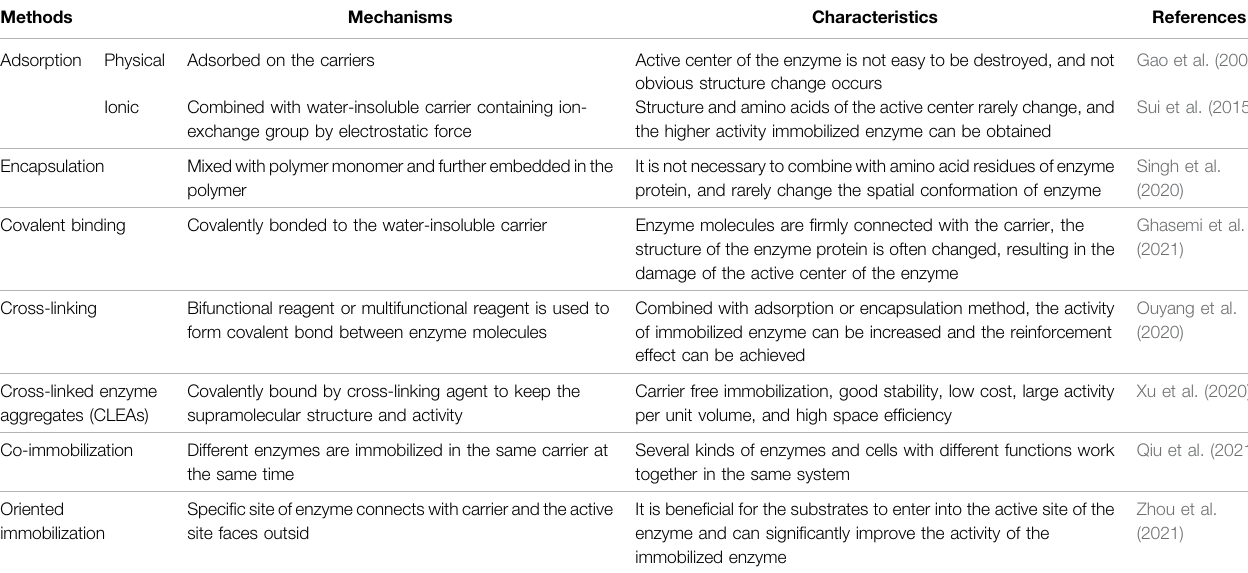
TABLE 1 | The characteristics of various immobilization method of